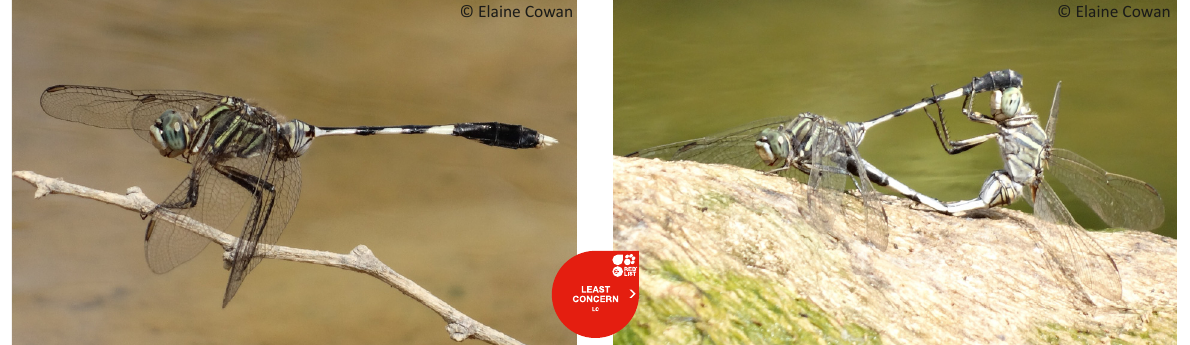
Image 17. Orthetrum sabina pair in mating wheel, 16 November 2013. Female (below) similar to but paler than male.